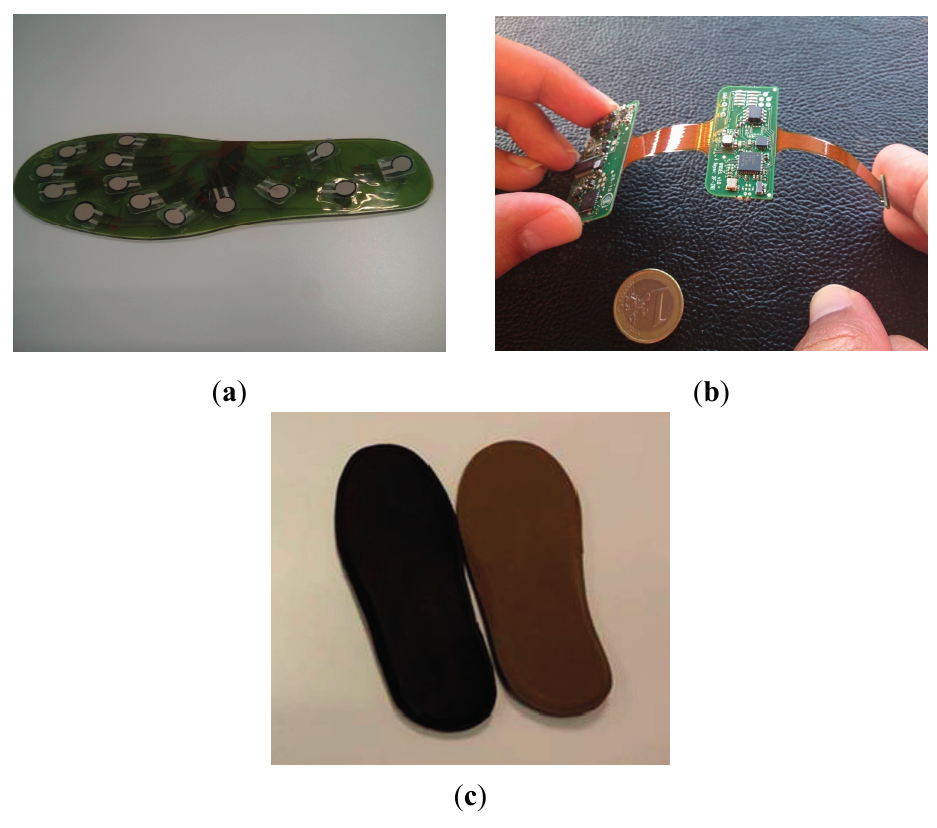
Figure 4. ( a ) 1mm polyurethane sensor layer; ( b ) PCB layer; and ( c ) top layer (black artificial leather) and bottom layer (Brown EVA